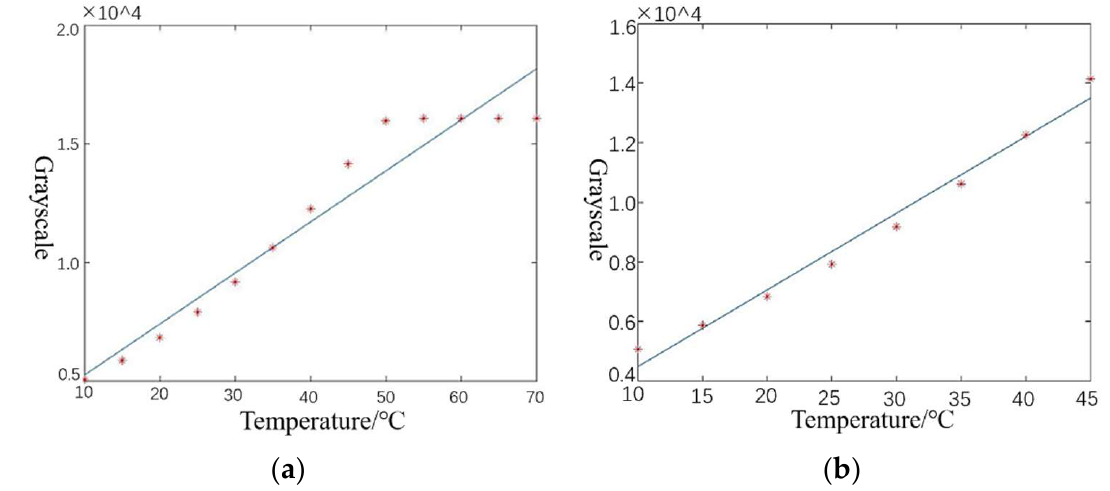
Figure 12. Fitting curve for two-point correction parameter: ( a ) fitted curve without removal of overexposure outliers; ( b ) fitted curve with removal of overexposure outliers. 10 4 Three thermal images are selected using the proposed method and processed by